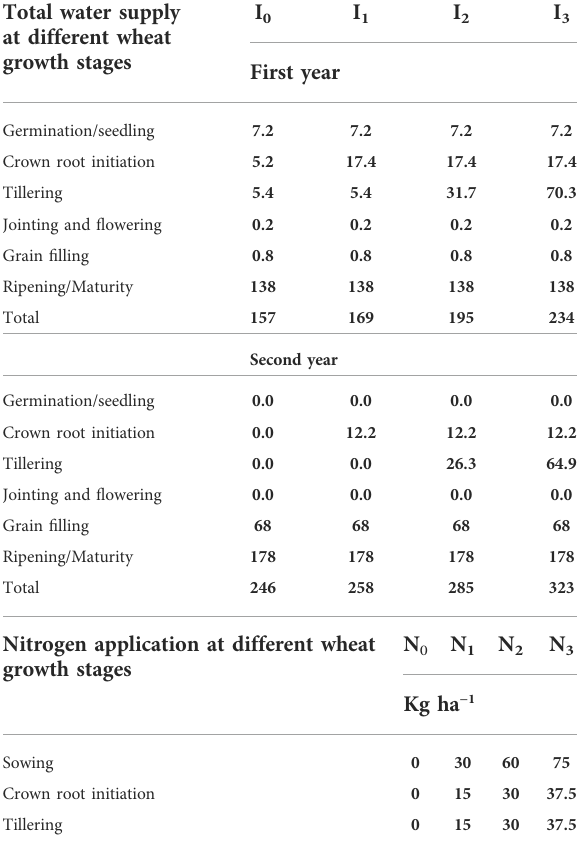
TABLE 2 Total water supply a (cm) and nitrogen application during the growth period of wheat crop for 2 years of the study. Total water supply at different